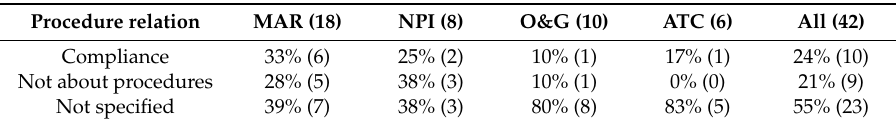
Table 4. Percentage (number) of papers that link CRM to compliance to procedures or that state CRM is beyond